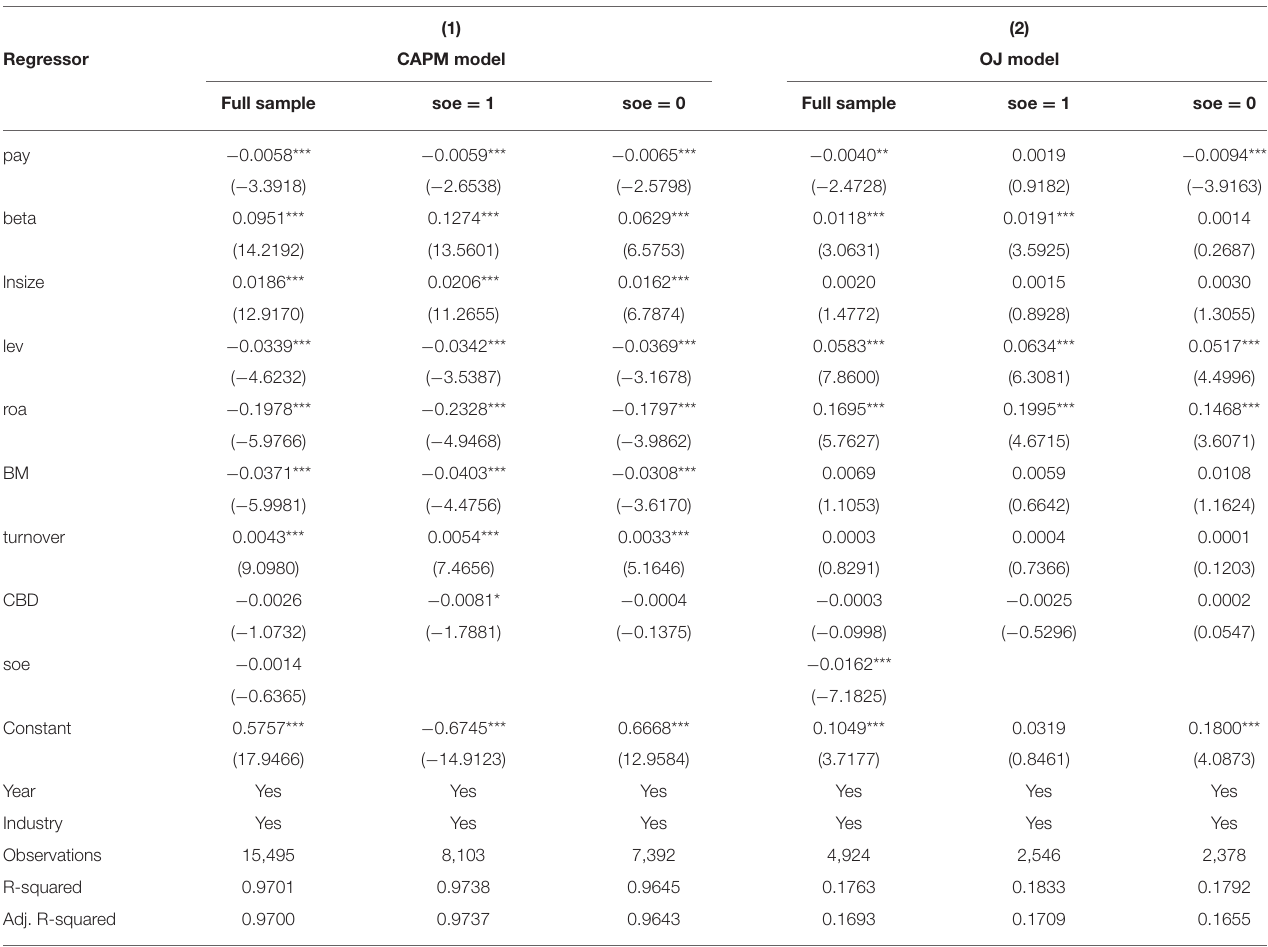
TABLE 8 | Alternative dependent variable: CAPM, OJ. (1)